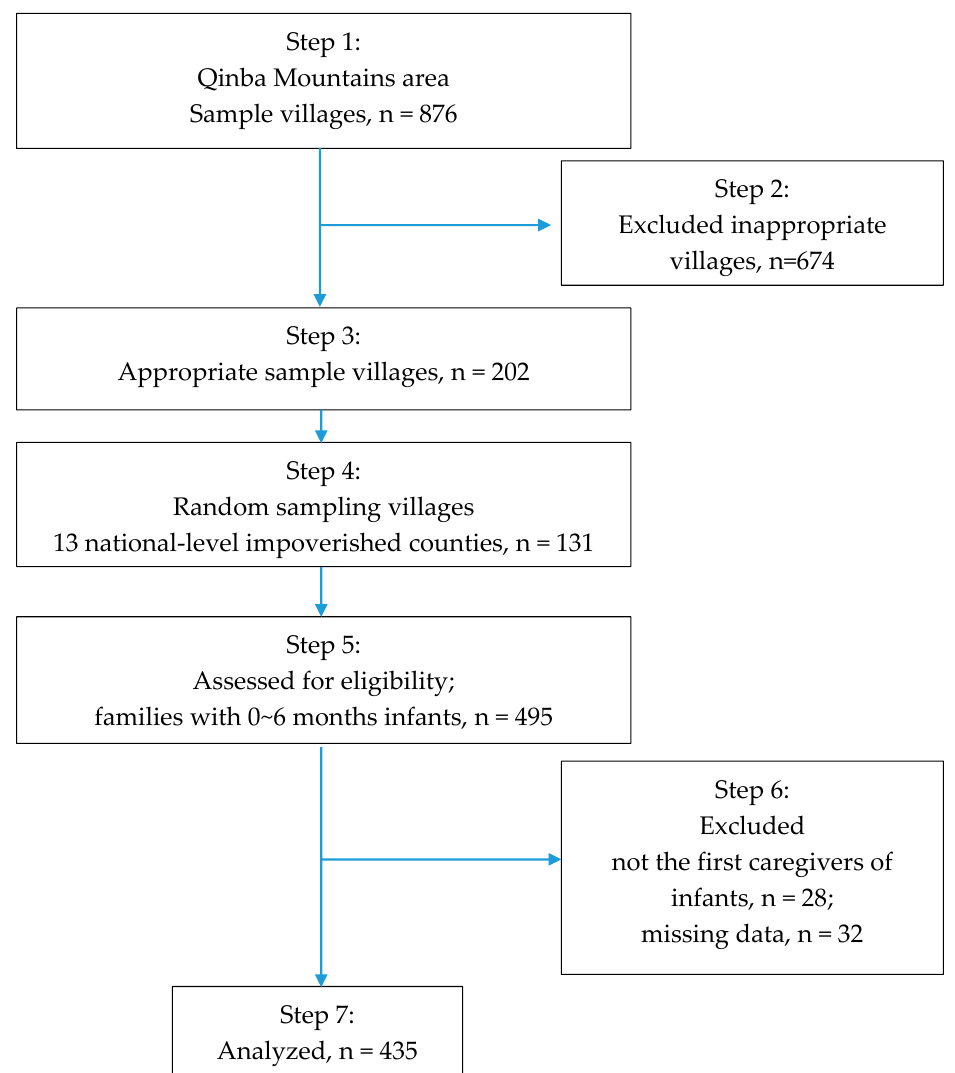
Figure 1. Flow diagram of sampling.